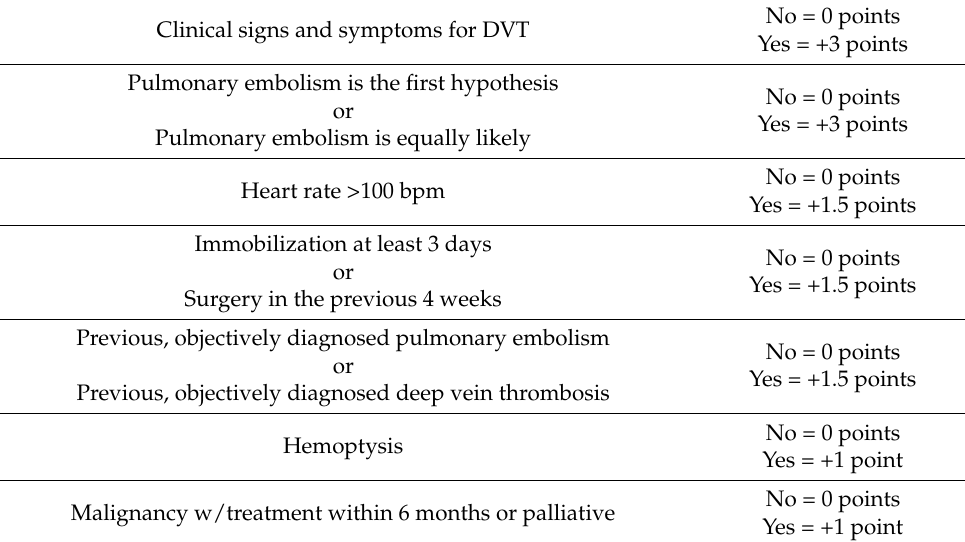
Table 1. Wells’ score for pulmonary embolism according to its original